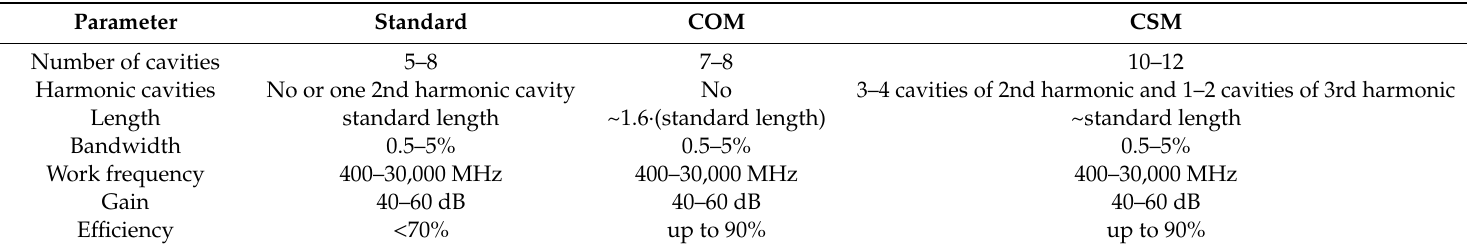
Table 1. Comparison of standard klystrons with COM and CSM ones.